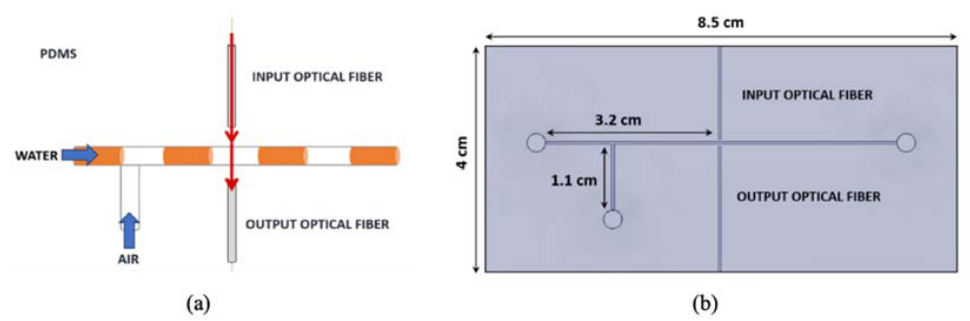
Figure 3. Working principle of the micro-optofluidic systems based on absorption ( a ); the CAD representation and measurements in a frontal perspective: the microfluidics T-junction and the optical fiber insertions ( b ).